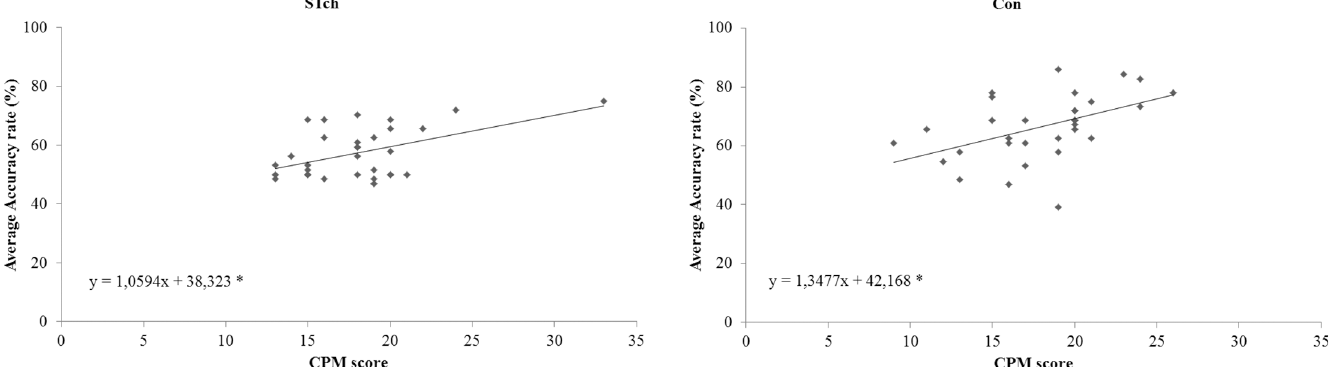
Fig 7. CPM-score predicts average Accuracy rate. Plots of CMP-score versus average Accuracy rate for street-children (STch) and controls (Con). * = p <